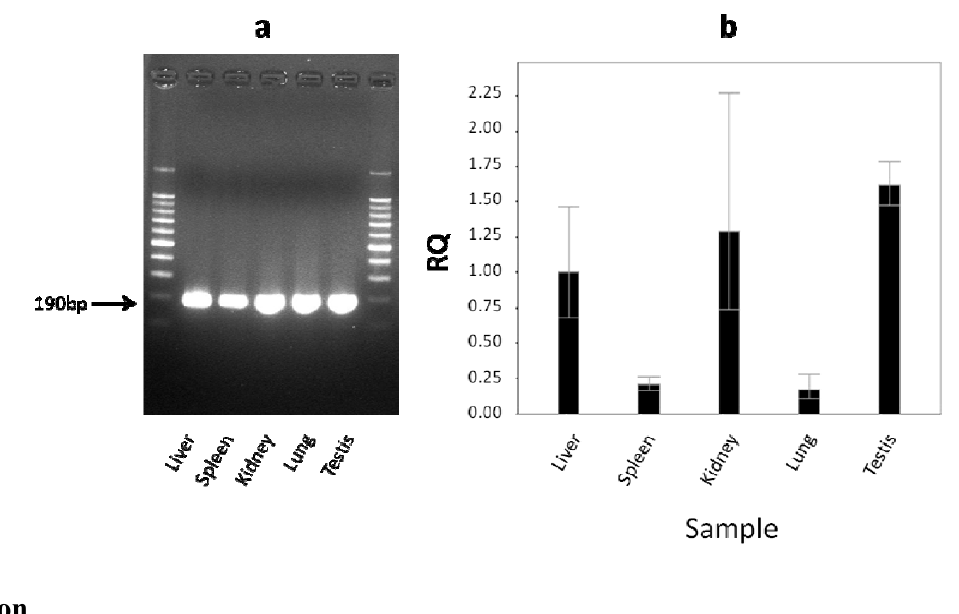
Figure 8. Expression of cLIPA in different camel tissues. ( a ) Semiquantitative PCR and ( b ) qPCR. The results of semiquantititive PCR indicated the specificity of the primers